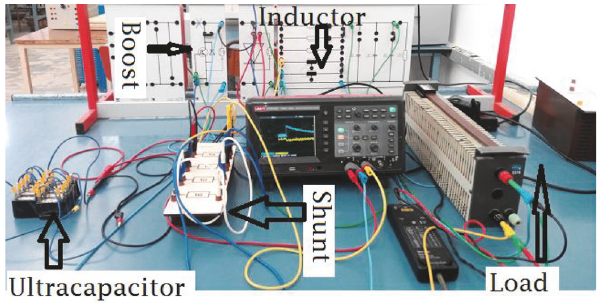
Figure 11: Test circuit.